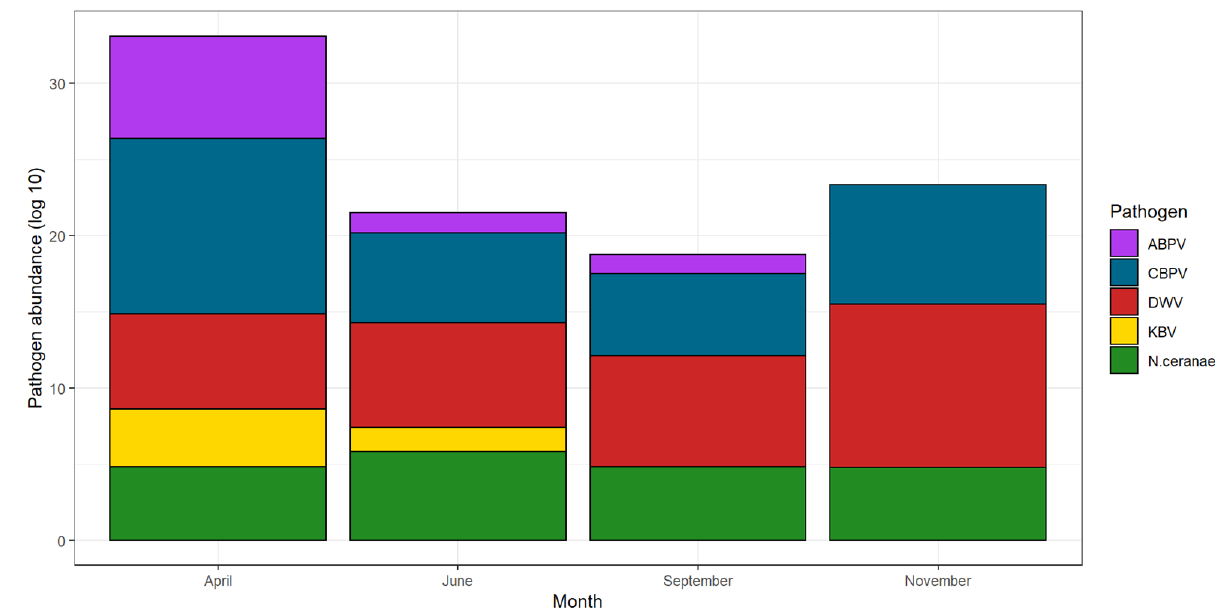
Figure 5. Cumulative pathogen abundance over the months. For a better visualization, data are shown as decimal logarithms.